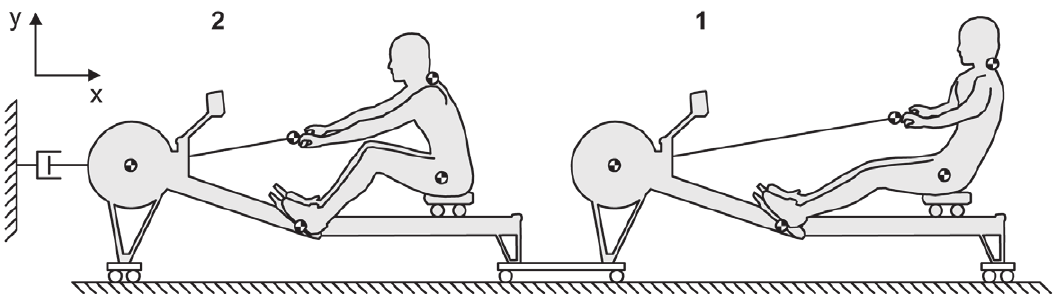
Figure 1. Schematic representation of the ergometer setup.